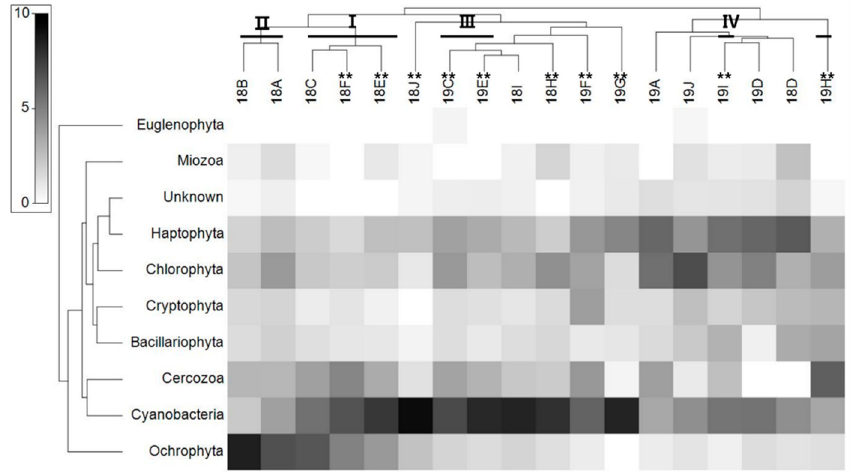
Figure 9. Shade plot illustrating the phytoplankton communities at the phylum level by site, for 18 samples. The plot depicts the relative abundance of phyla within microbial communities. **: >1,000,000 copies/mL (rDNA of C. polykrikoides ) . Table 8. Strongly correlated phytoplankton OTUs with C. polykrikoides